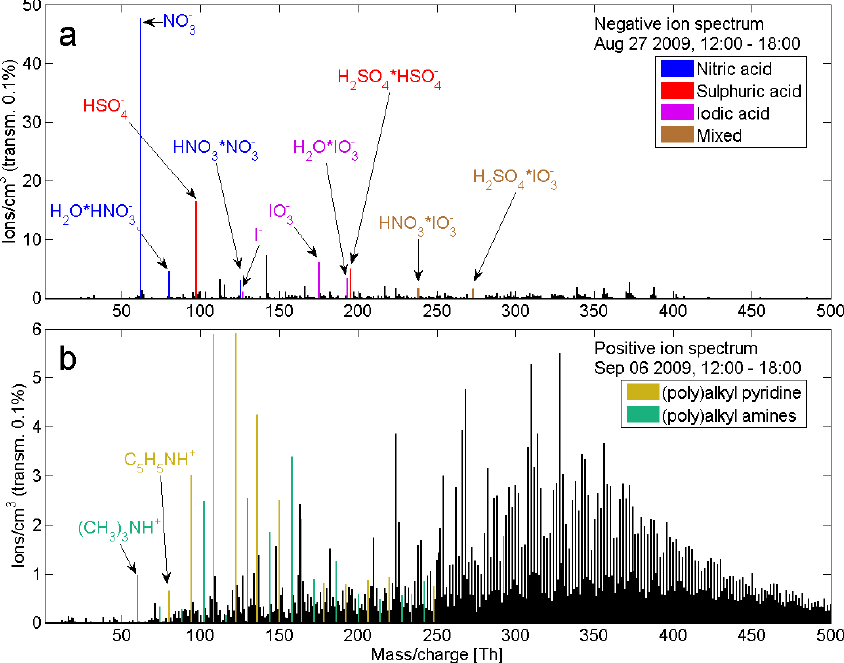
Fig. 10. Example ambient ion mass spectra. Top panel (a) shows negative ions and bottom panel (b) shows positive ions. The negative ion spectrum is dominated by strong acids and is much easier to interpret, while the positive ions spectrum is more evenly spread out over a large range of masses. Black bars represent peaks without chemical identification.